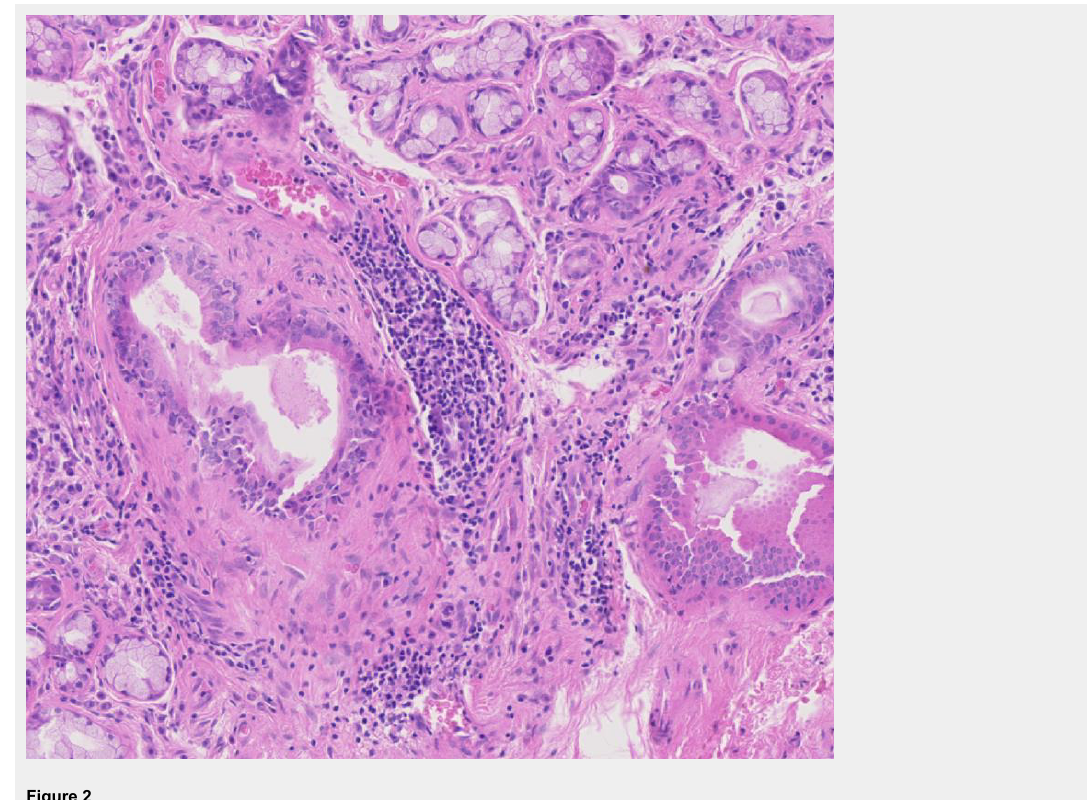
Figure 2 Haematoxylin and eosin staining of labial salivary gland biopsy with evident lymphoepithelial